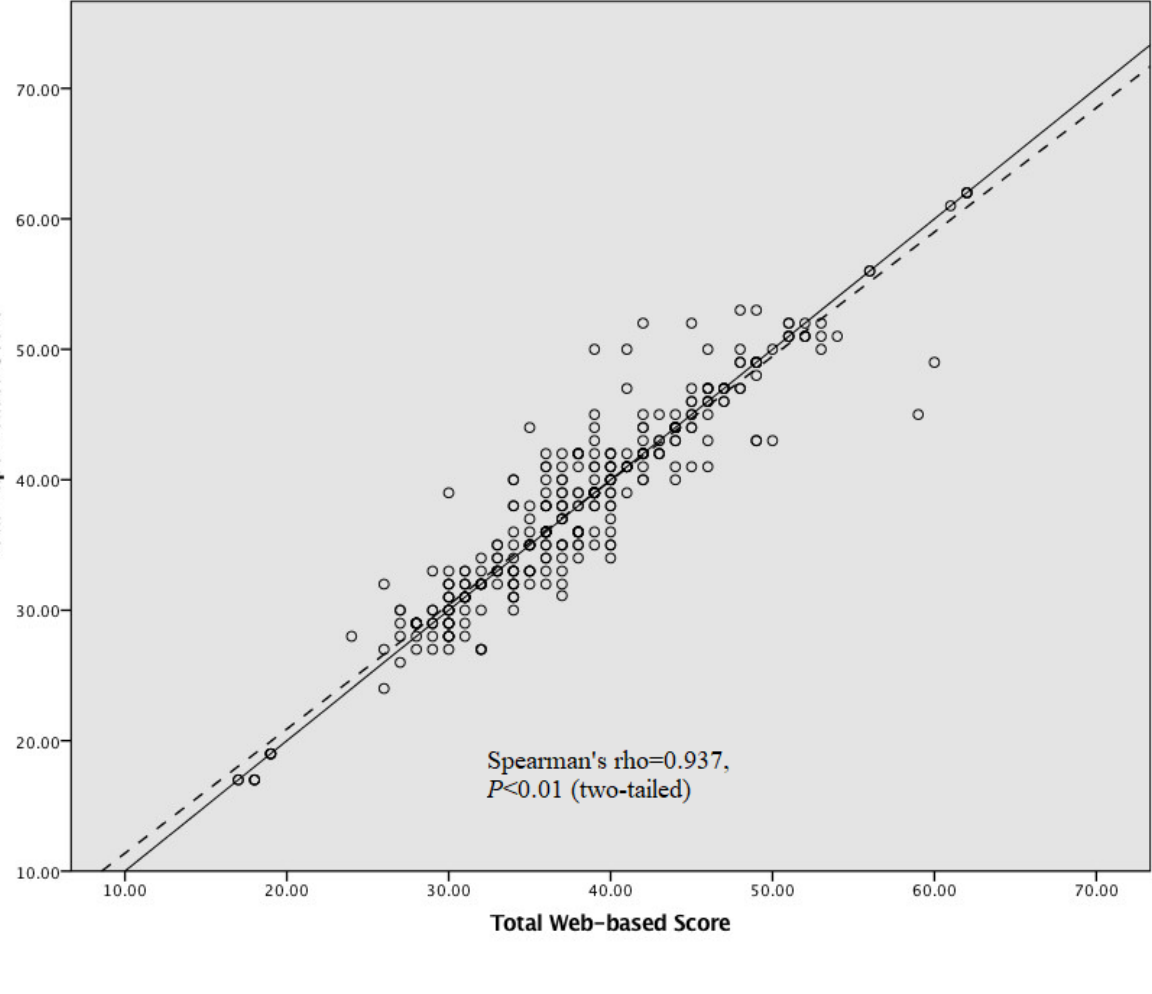
Figure 3. Correlation between total paper-based and web-based